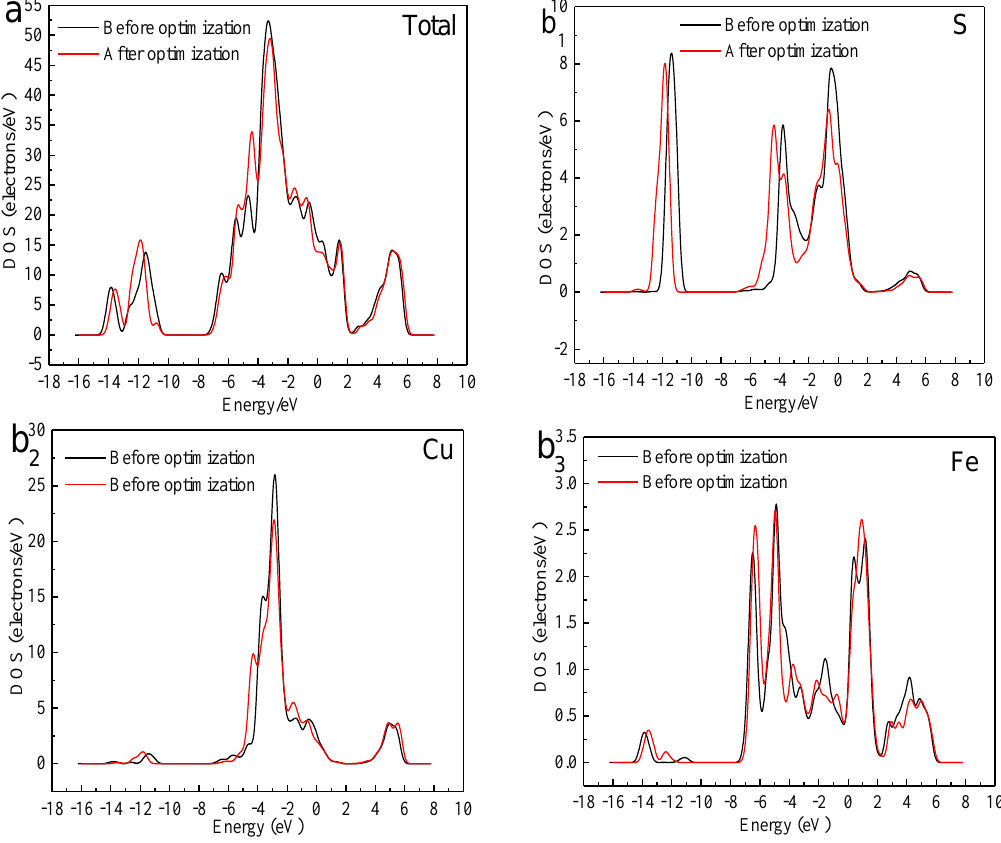
Figure 7. Local DOS of bornite before and after optimization (CASTEP module of Materials Studio 6.0 software package, PBE density function, Hubbard + U correction): ( a ) Total; ( b 1 ) S; ( b 2 ) Cu; ( b 3 ) Fe in DFT calculation.